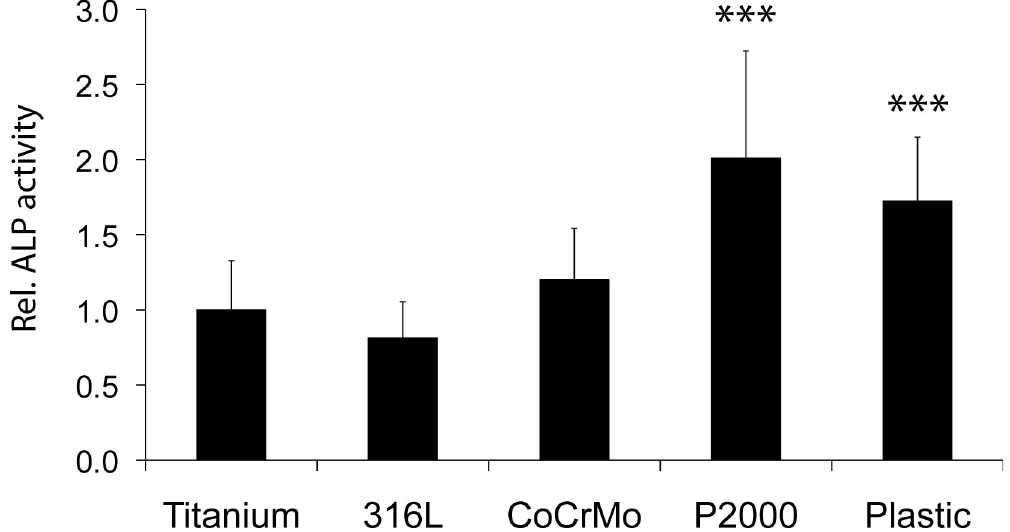
Fig 3. Alkaline phosphatase (ALP) activity. Osteoblasts grown for 1 week on different samples in mineralization medium were stained for ALP activity by a colorimetric test. Cells grown on plastic cell culture plate served as positive control. Cells on RM-A controls died completely after 1 week. Data are presented as mean ± S.E.M. Student’s t-test. ��� p < 0.001).